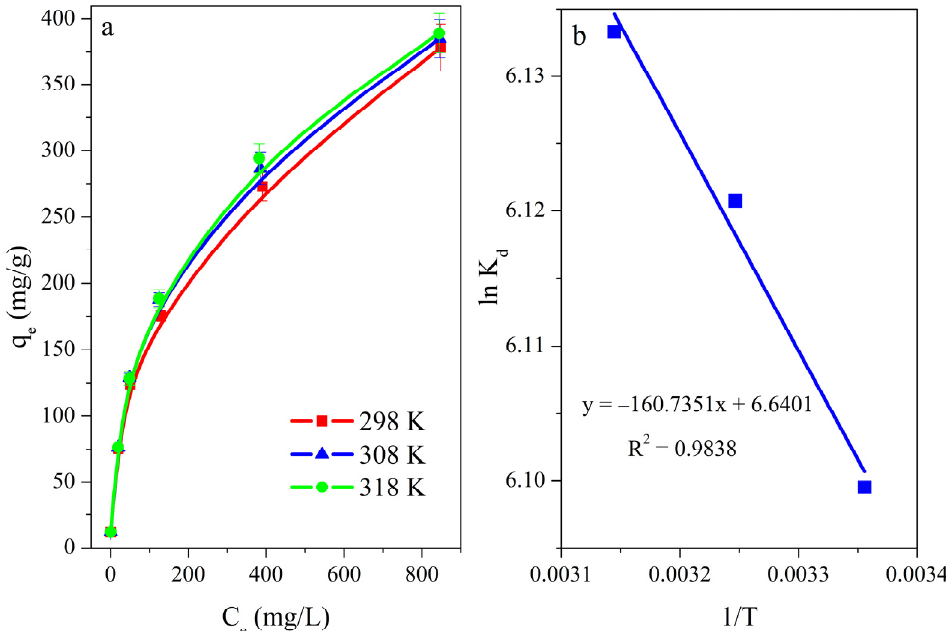
Figure 4. ( a ) Adsorption isotherms of phosphate on MTPG; ( b ) plots of ln K d vs. 1/ T . (C 0 = 5–1000 mg/L, MTPG = 0.4 g/L, pH = 5, t = 24 h). Table 3. Relative parameters of sorption isotherms models.